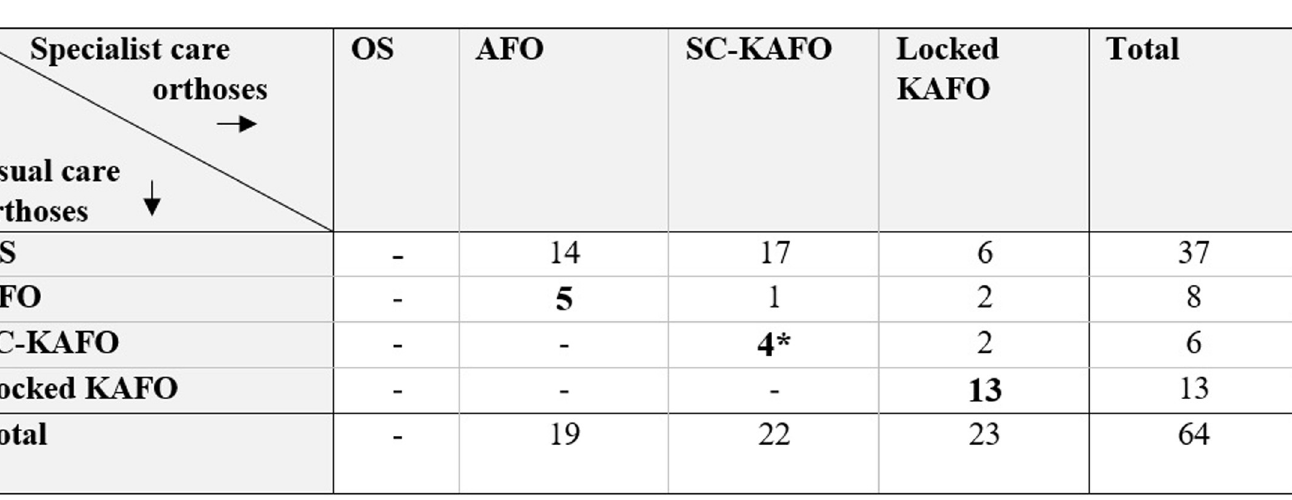
(IQR) time between baseline and follow-up measurements was 13.0 (8.0) months. Baseline demographics and clinical characteristics of all 64 subjects, and for subgroups according to specialist care orthosis type, are presented in Table 1.